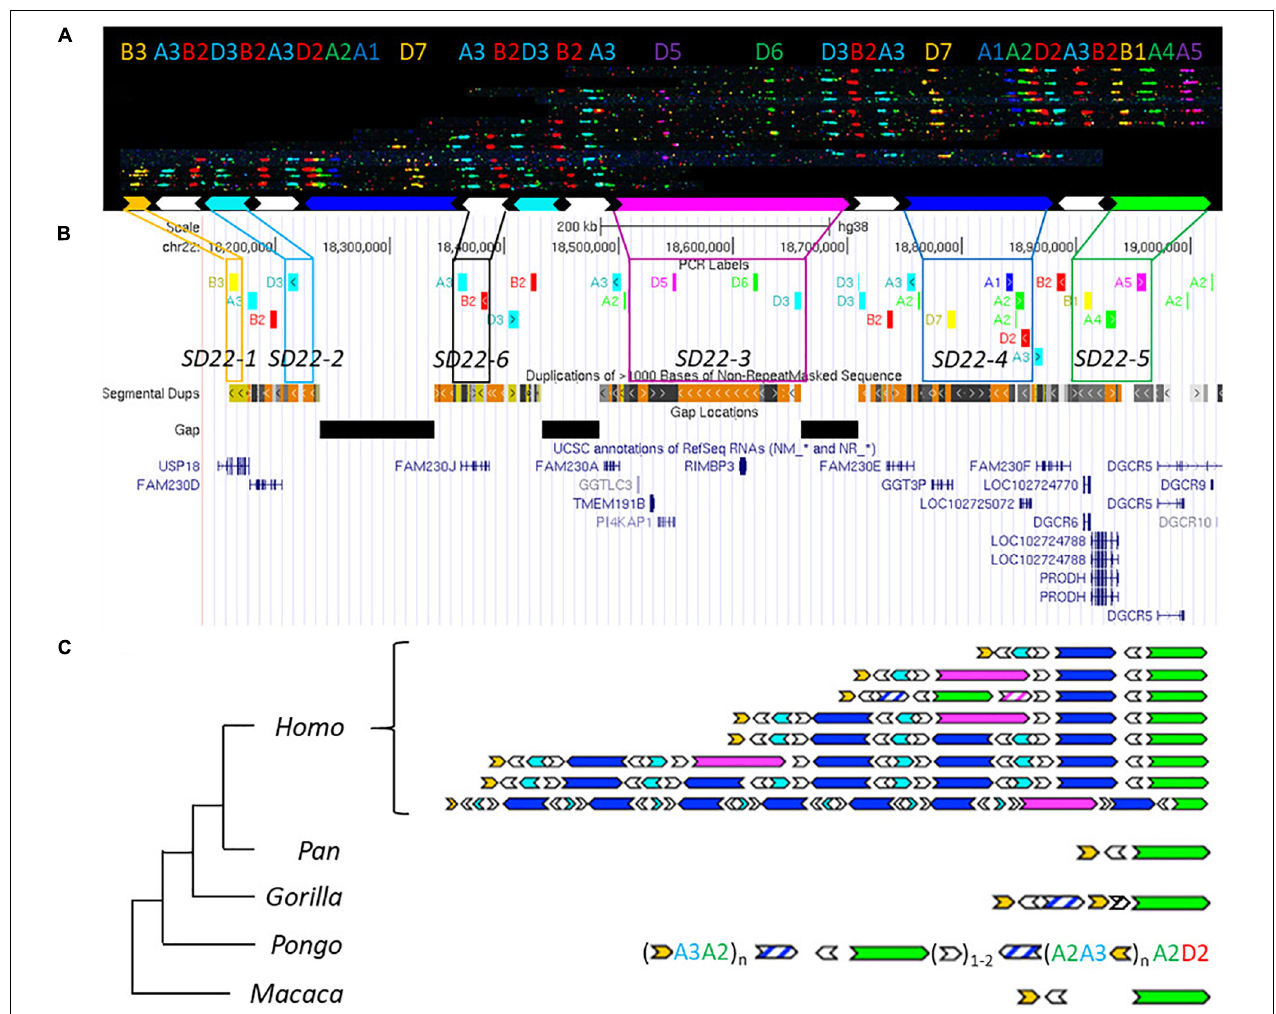
FIGURE 3 | Human duplication structure and evolutionary analysis of LCR22-A. (A) De novo assembly of a LCR22-A haplotype. Individual fibers with probe patterns are collected during the analysis of the fiber-FISH slide and later compiled based on matching colors and distances between the probes. SD22 duplicons are assigned to specific probe combinations. (B) UCSC Genome Browser hg38 reference screenshot, with tracks for fiber-FISH probe BLAT positions, segmental duplications, gaps, and RefSeq genes. Assigned duplicons in (A) are decomposed to their corresponding fiber-FISH probes in this reference screenshot. (C) Evolutionary tree representation of the observed LCR22-A haplotypes. Only a subset of assembled haplotypes are depicted for human, to emphasize the human hypervariability. Filled, colored arrows represent copies of duplicons, and hatched arrows represent partial copies of duplicons of the same